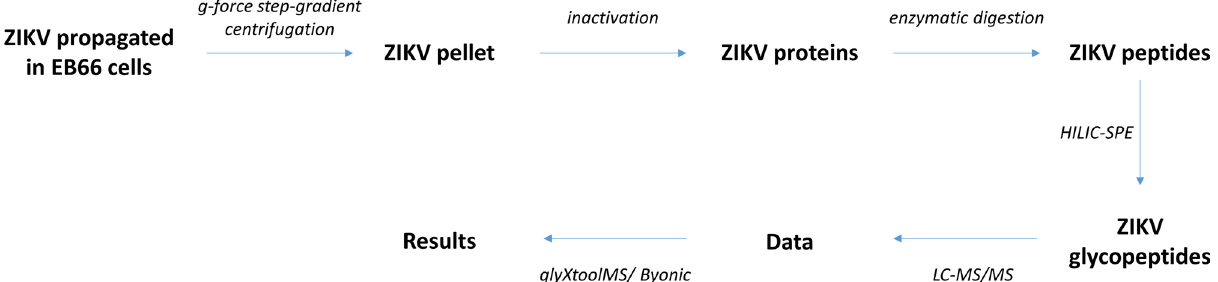
Figure 1. Workflow of the site-specific N -glycopeptide analysis of ZIKV